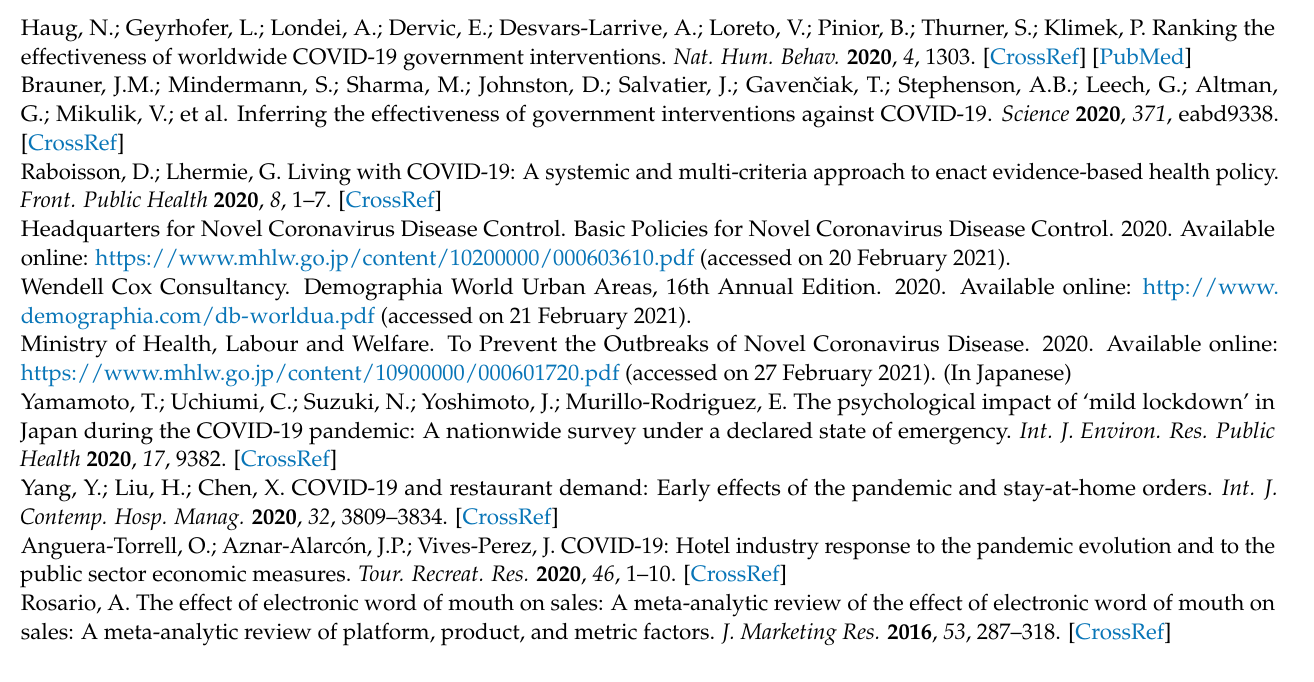
eWOM mass compared with real metrics. Table S1: Parametrization of quantitative model. Table S2: Parametrization in each intervention